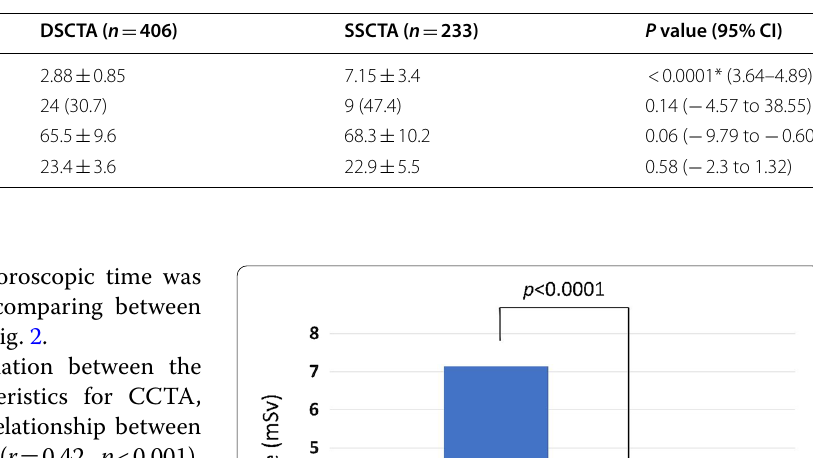
Table 4 Comparison of radiation dose and patient characteristics between dual-source CTA (DSCTA) in 2019 and single-source CTA (SSCTA) in